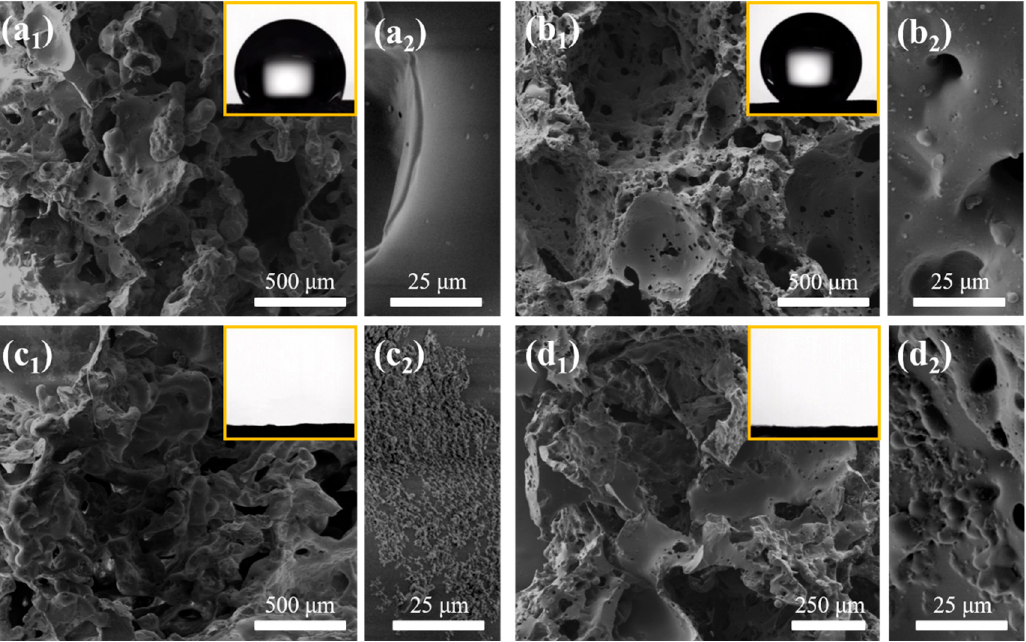
Figure 2. SEM images of porous PDMS ( a 1 ), CNT-PDMS ( b 1 ), PDA/PDMS ( c 1 ), and PDA/CNT-PDMS ( d 1 ) prepared with the m-CAM template. ( a 2 – d 2 ) are the corresponding zoomed SEM images. The inset in the upper-right corner of ( a 1 – d 1 ) shows the water contact angle on the corresponding sponge surface.